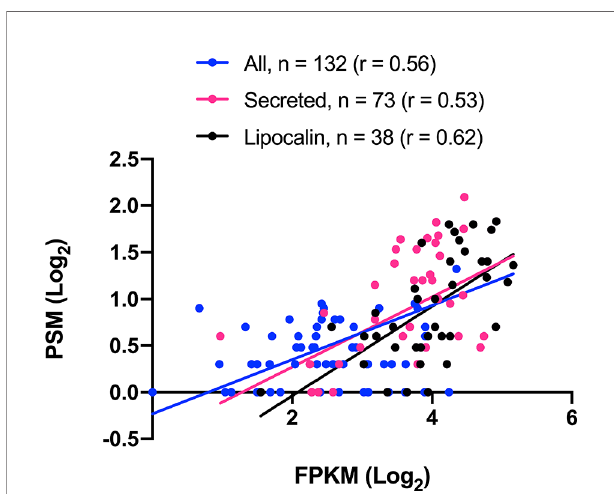
FIGURE 1 | Triatoma sordida salivary transcriptome/proteome correlation. The scatterplot illustrates the Pearson ’ s correlation ( r. ) between CDS (FPKM) and proteins (spectrum count) from T. sordida salivary gland transcriptome and salivary gland extract proteome. It shows a statistically signi fi cant P value (p<0.0001) in the three groups tested: All identi fi ed proteins (blue), Secreted identi fi ed proteins (pink), and Lipocalin identi fi ed proteins